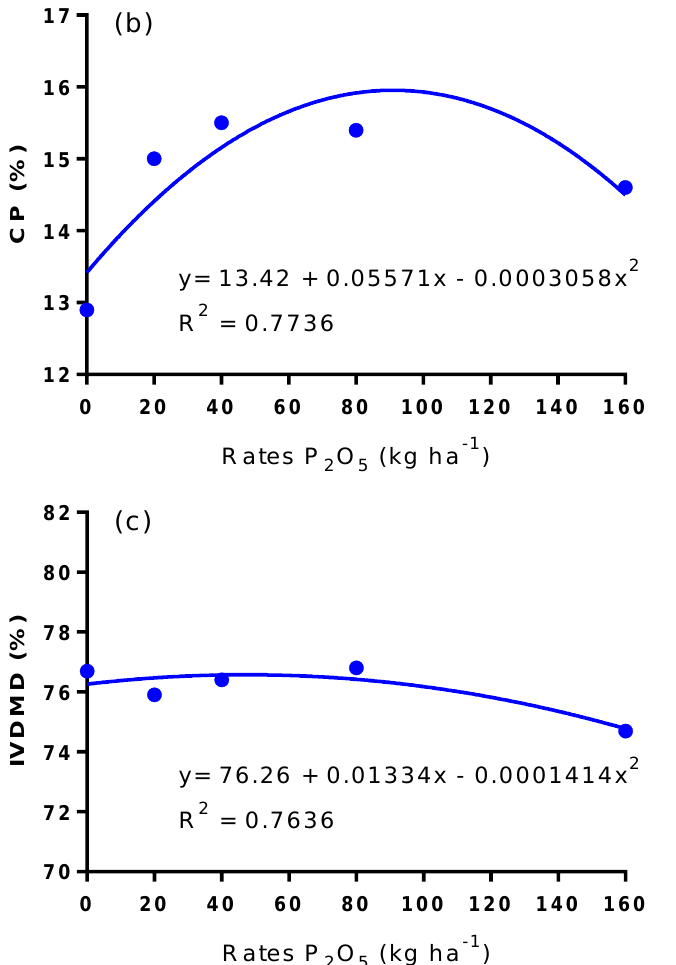
Figure 7. Regression equation of acid detergent insoluble fiber (ADF) ( a ), crude protein (CP) content ( b ) and in vitro true digestibility of dry matter (IVDMD) ( c ) of Mavuno grass as a function of phosphorus sources and rates in the presence and absence of polymers in dystrophic Ultisol.